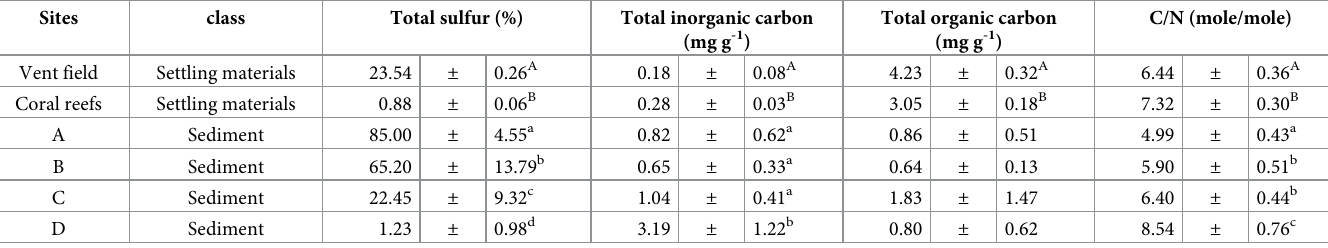
Table 2. Elemental composition in sediment and trap samples collected from each